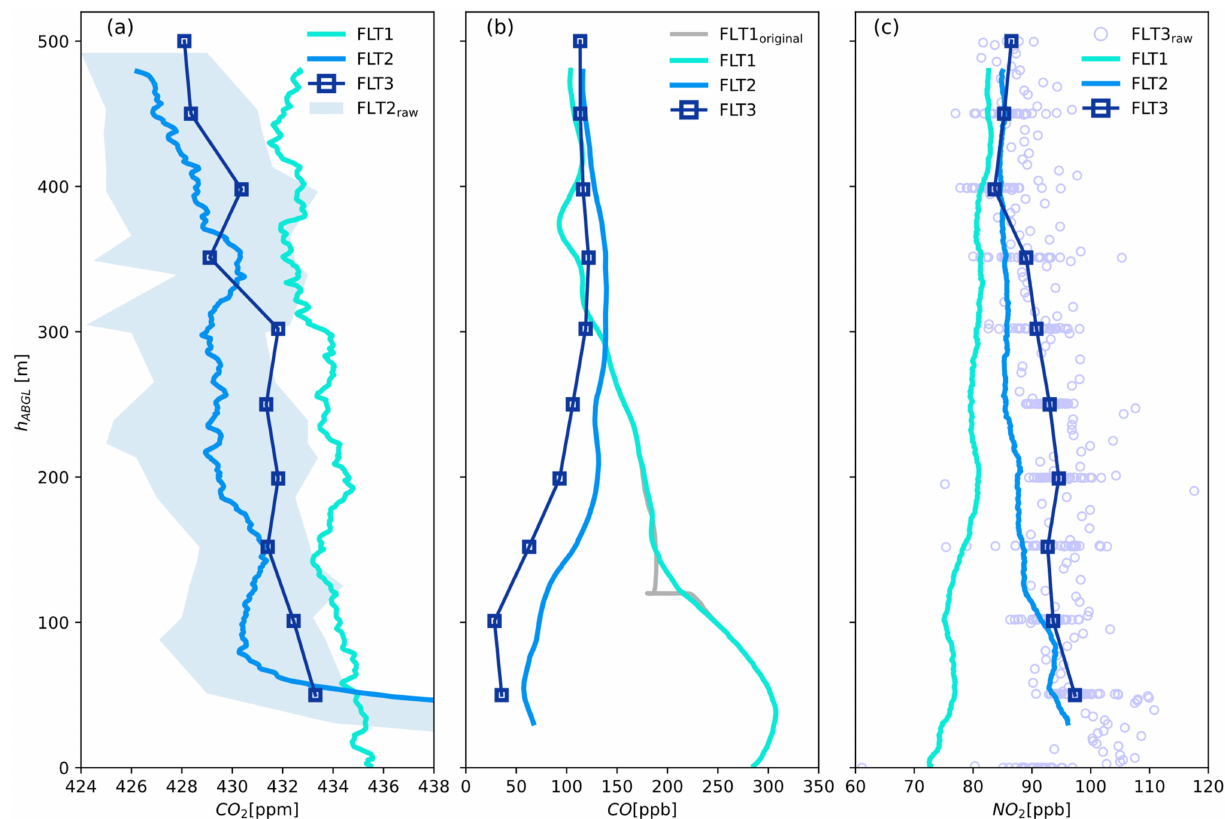
Figure 10. Vertical atmospheric profile of mole fraction density distributions for CO 2 ( a ), CO ( b ) and NO 2 ( c ) during ascent of all three test flights at Yanqing, Beijing. While the moving averages of measurements of the first two flights are plotted with continuous lines, the third flight is exhibited in connected dots (accepted measurements for each height level) due to its distinctive flight